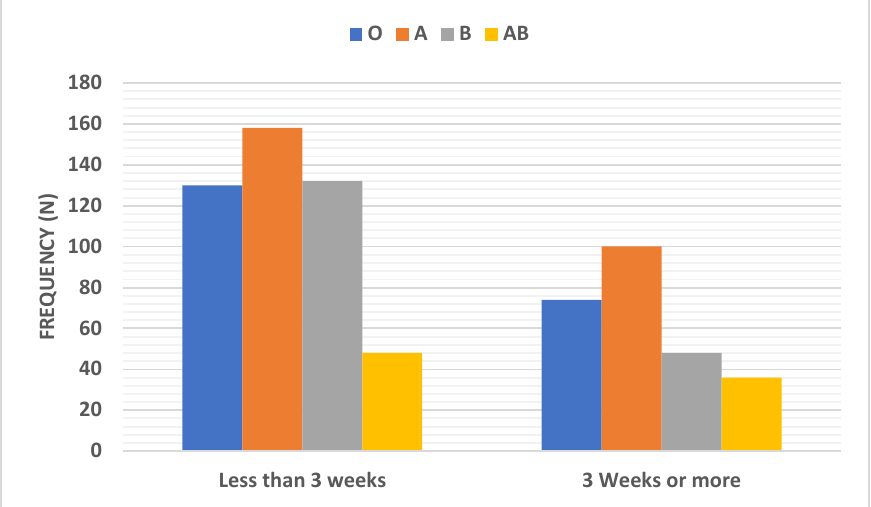
Figure 8. Distribution of recovery time among COVID-19 patients according to the ABO blood group type. Data were presented as frequency (number).